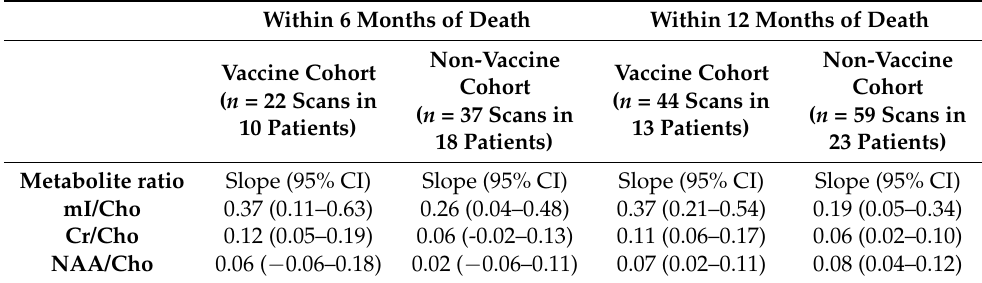
Figure 3. Association between metabolite ratios and overall survival in the non-vaccine cohort, at diagnosis ( n = 23, left column), and at 3 timepoints defined relative to date of diagnosis to align with